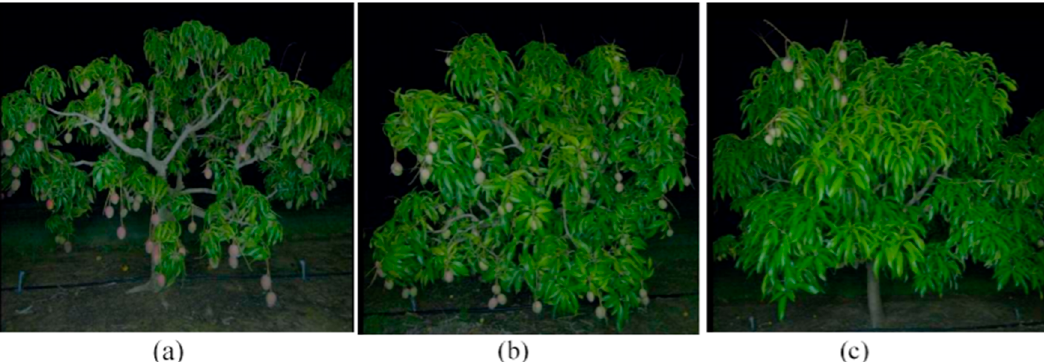
Figure 2. Images of canopies associated with mango fruit loads of ( a ) 60, ( b ) 40 and ( c ) 8 tonnes per ha, with tree density of 400 trees/ha.